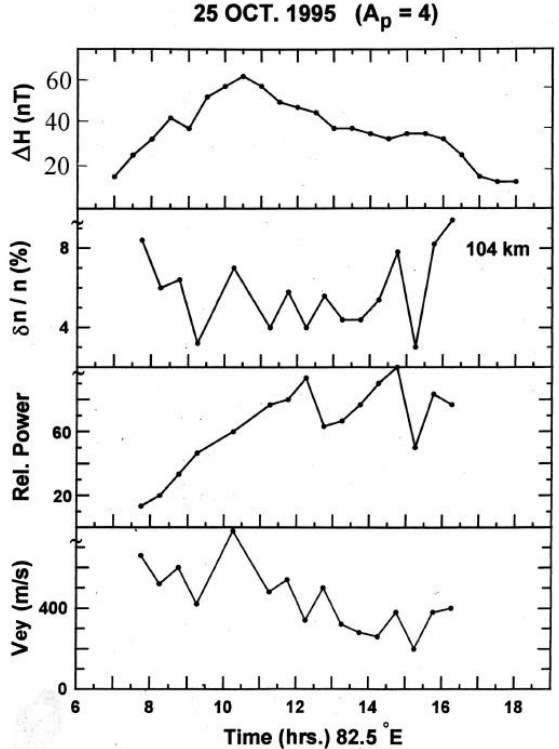
Fig. 9. Same as Fig. 5, but for 25 October